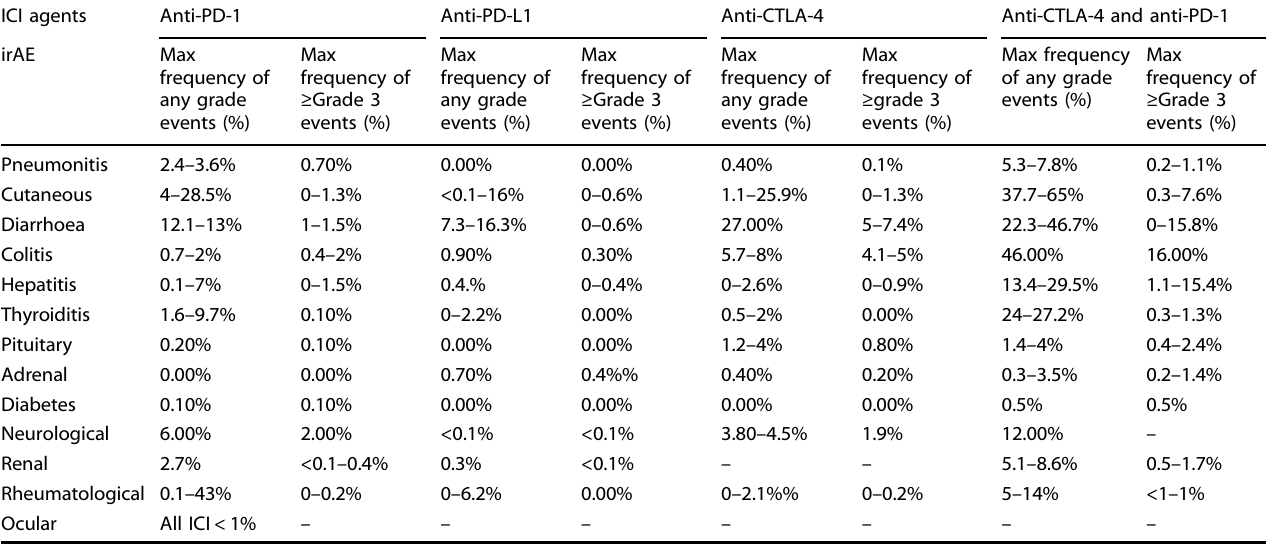
Table 1. Frequency of different side effects by ICI treatment type.